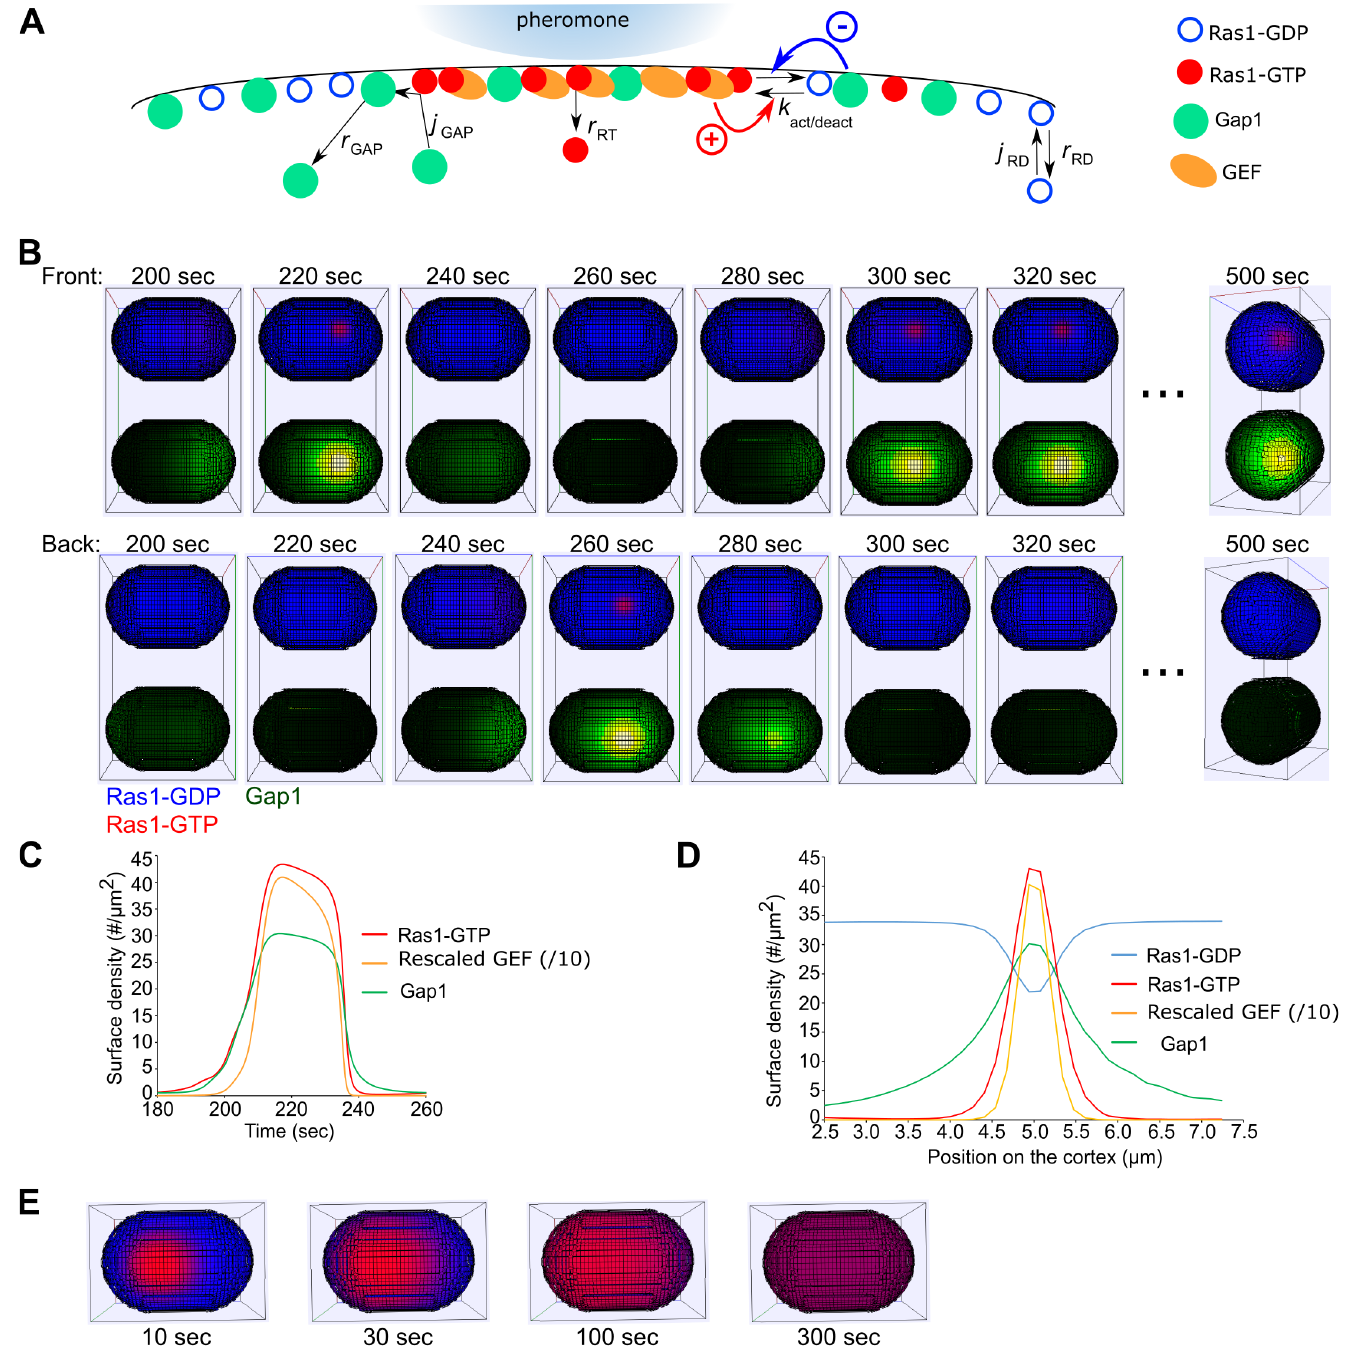
Fig 4. Model for Ras1 patch formation and exploration. (A) Schematic illustrating the model of Ras1 patch formation along the cell membrane. Stabilization can occur in a region with higher external pheromone concentration. (B) Snapshots of simulation showing appearance and disappearance of a patch on the surface of one cell. The top displays illustrate Ras1-GDP (blue) and Ras1-GTP (red). The bottom ones show Gap1 (green). Note that the first and second rows show views of the front and the upside down back of the same cell, illustrating the movement of a patch to a different cortical location. For this and following panels, the model parameters are from Table 1, unless otherwise indicated. (C) Simulated protein surface density at the center of a patch over time during patch appearance and disappearance. (D) Surface density profile over a 0.2 μm wide strip along the cell long axis going through the center of the patch at 220 sec for the simulation shown in panel B. (E) Elimination of negative feedback by setting the Gap1-dependent hydrolysis rate constant of Ras1-GTP equal to zero results in global activation of Ras1, similar to gap1 Δ cells.